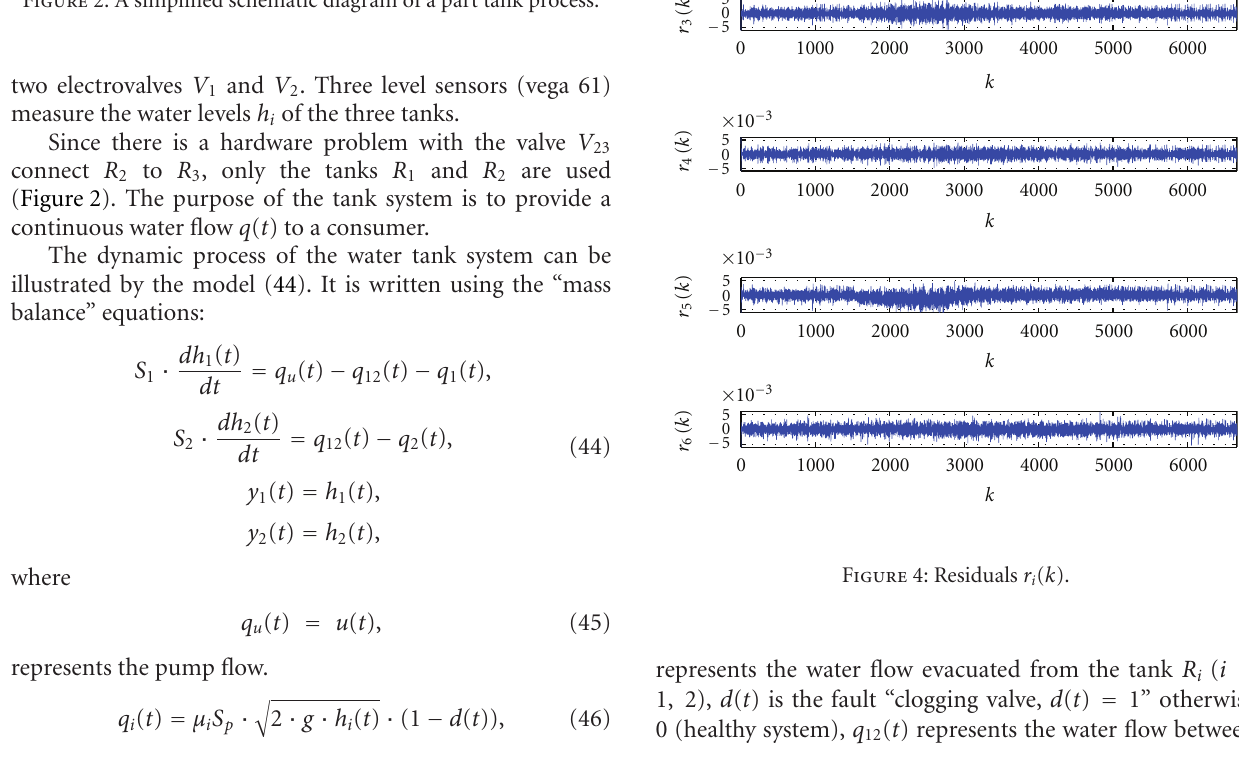
Figure 2: A simplified schematic diagram of a part tank process.